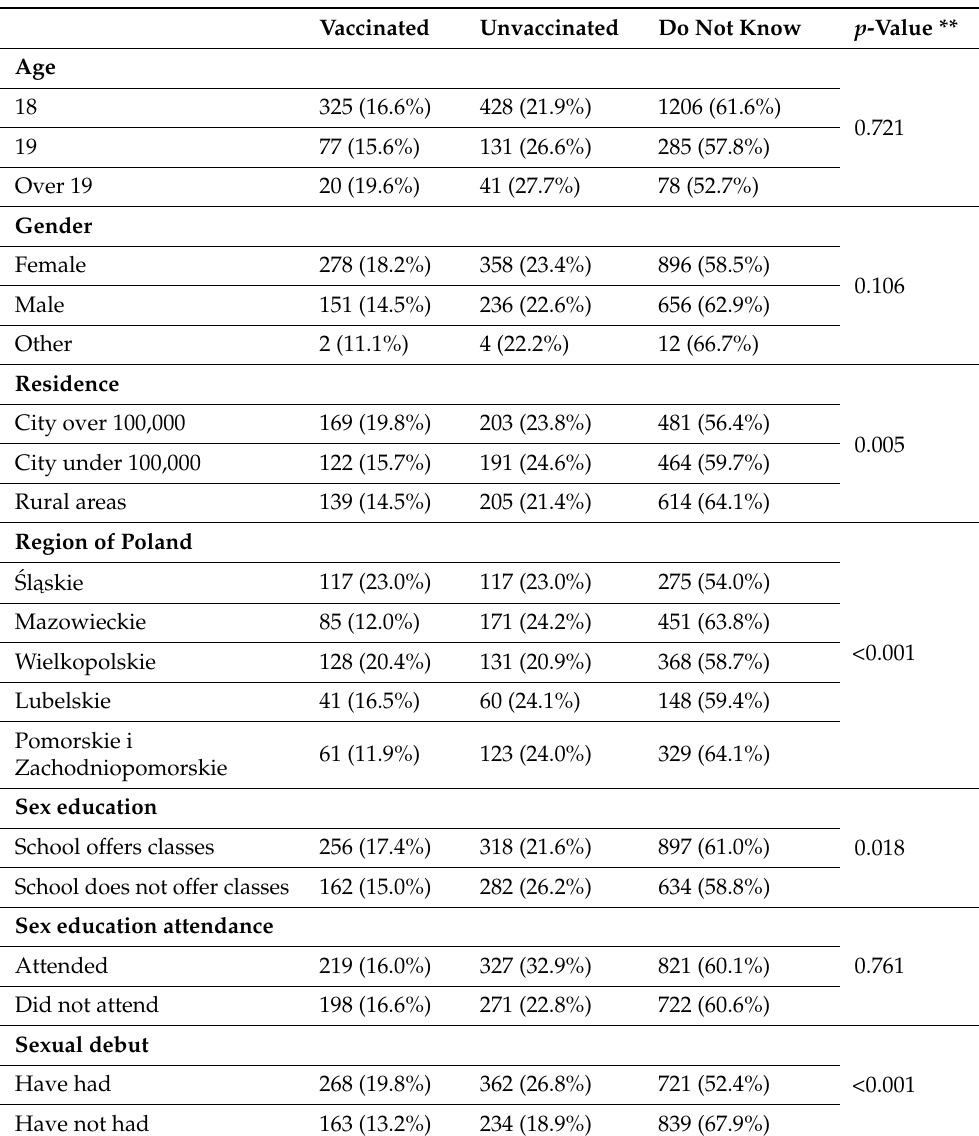
Table 2. Characteristics of the sample by vaccination status ( n = 2605) (%) * ( p -values from chi-square tests for difference in proportion of HPV vaccination across ages, genders, residences, regions, sex education, sexual